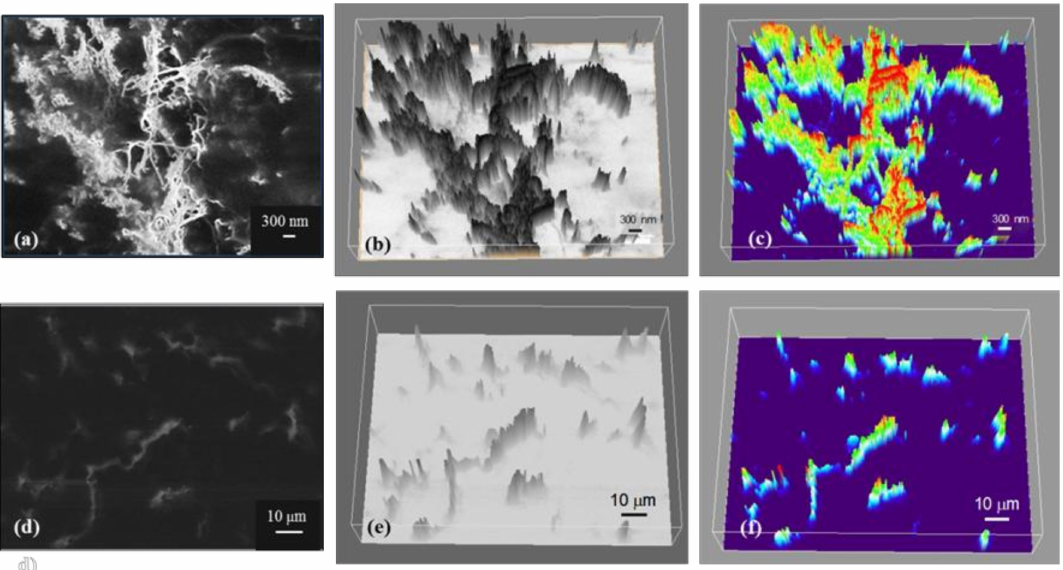
Figure 8. Top: 0.75% wt CNT composite showing the CNT forming a network within the epoxy matrix. ( a ) Original SEM secondary electron image; ( b ) 3D surface plot generated from greyscale image and ( c ) 3D surface plot ‘thermal’ image. Bottom: 0.014% wt CNT composite structure; ( d ) SEM micrograph showing unconnected strings on CNTs; ( e ) 3D surface plot greyscale image and ( f ) 3D surface ‘thermal’